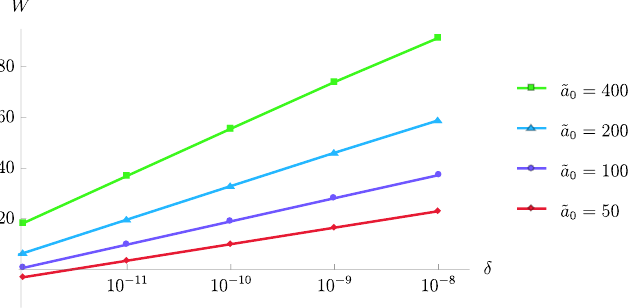
Figure 7 . The suppression rate (cid:22) W as a function of (cid:14) and for several choices of ~ a 0 . One observes the logarithmic dependence, which excludes the possibility to treat (cid:14) as a semiclassical parameter. central value of the Higgs mass m = 125 : 09 GeV [75]. The (cid:12)eld-dependent momentum H scale ^ (cid:22) = ^ (cid:22) ( (cid:18) ) is chosen according to the prescription (see section